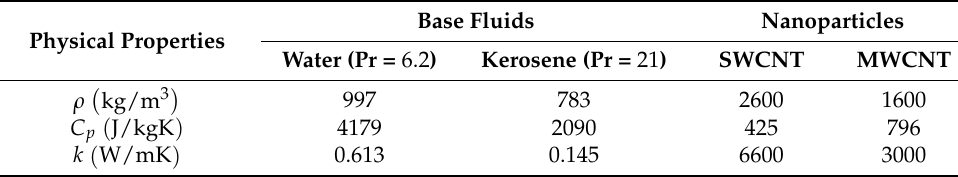
Table 1. Thermophysical properties of base fluids and carbon